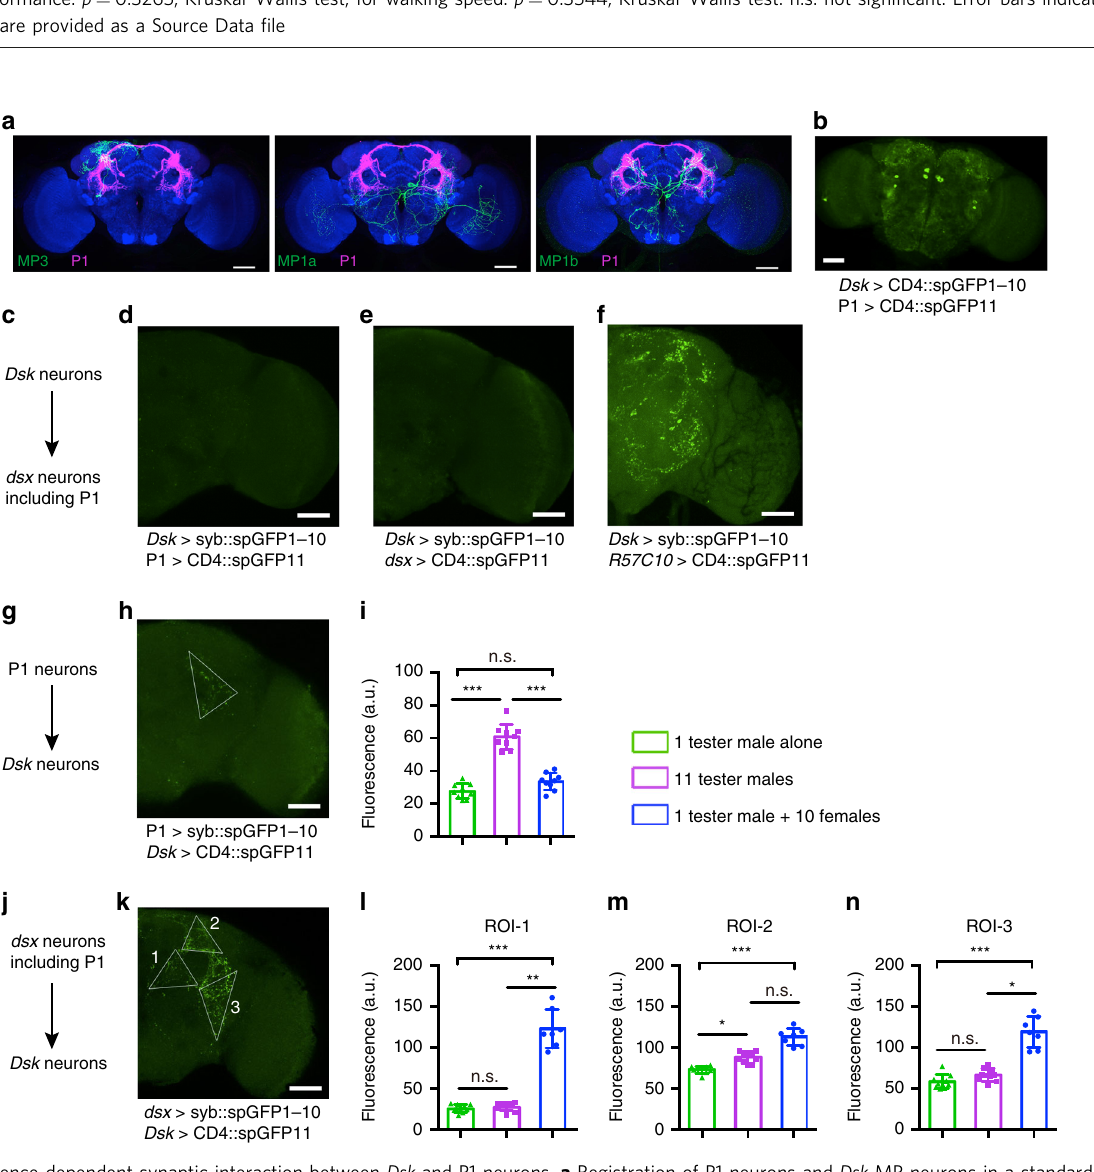
Fig. 5 Experience-dependent synaptic interaction between Dsk and P1 neurons. a Registration of P1 neurons and Dsk MP neurons in a standard brain. b Potential membrane contacts between P1 and Dsk neurons as revealed by conventional GRASP technique. Representative of fi ve male brains. c – f There is no syb-GRASP signal from Dsk neurons to dsx neurons including P1 neurons. Representative of fi ve male brains for each genotype. g – i Experience- dependent synaptic transmission from P1 neurons to Dsk neurons as revealed by syb-GRASP signals. n = 9 for each. p < 0.001, One-way ANOVA. *** p < 0.001, post hoc Tukey ’ s multiple comparisons test. j – n Experience-dependent synaptic transmission from dsx neurons (including P1 neurons) to Dsk neurons as revealed by syb-GRASP signals in single-housed males (green bar) and group housed males (magenta bar for male – male group, and blue bar for male – female group). n = 10, 10 and 7 for each group respectively. For ROI-1: p < 0.001, Kruskal – Wallis test. ** p < 0.01, *** p < 0.001 and p > 0.99 (n.s.), post hoc Dunn ’ s multiple comparisons test. For ROI-2: p < 0.001, Kruskal – Wallis test. * p < 0.05, *** p < 0.001 and p = 0.08 (n.s.), post hoc Dunn ’ s multiple comparisons test. For ROI-3: p < 0.001, Kruskal – Wallis test. * p < 0.05, *** p < 0.001 and p = 0.31 (n.s.), post hoc Dunn ’ s multi p le comparisons test. n.s. not signi fi cant. Error bars indicate SEM. Source data are provided as a Source Data fi le NATURE COMMUNICATIONS| (2019) 10:4770